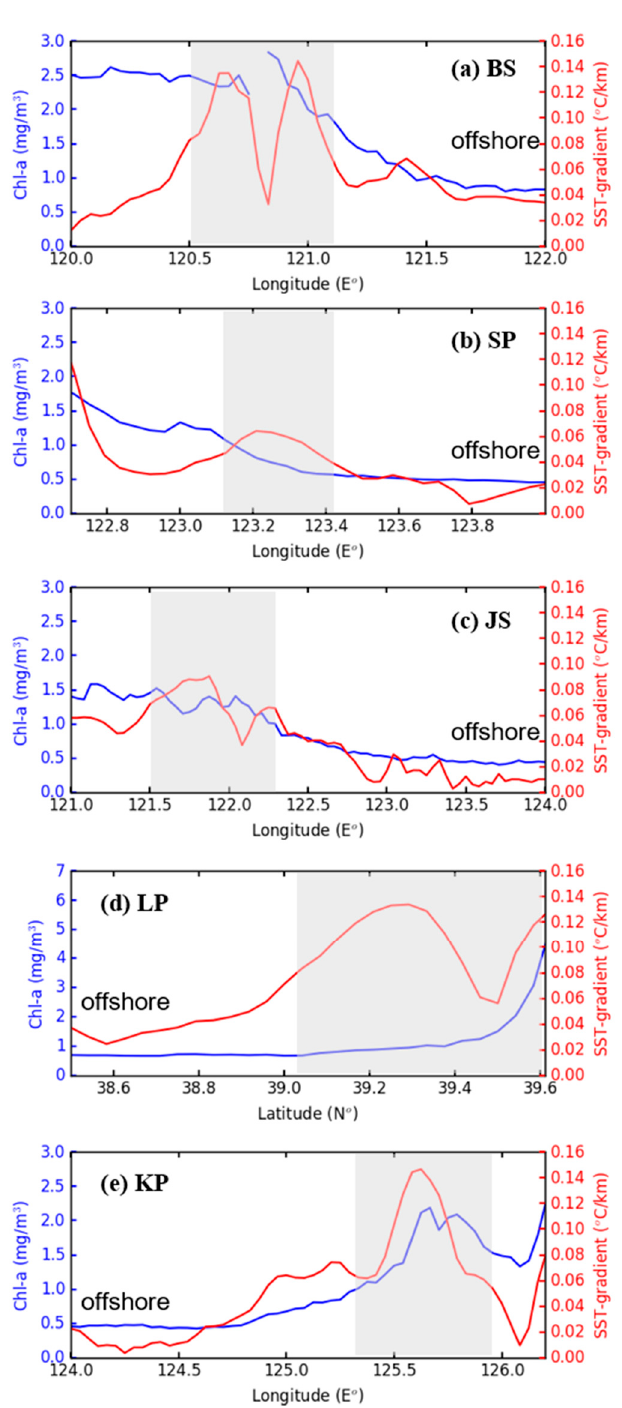
Figure 11. Chl-a concentration and SST gradient across the five fronts in August. ( a–e ) Transects along 38.3° N, 37° N, 34° N, 123.8° E, and 37° N, respectively. The gray shadings indicate the SST-frontal zones.